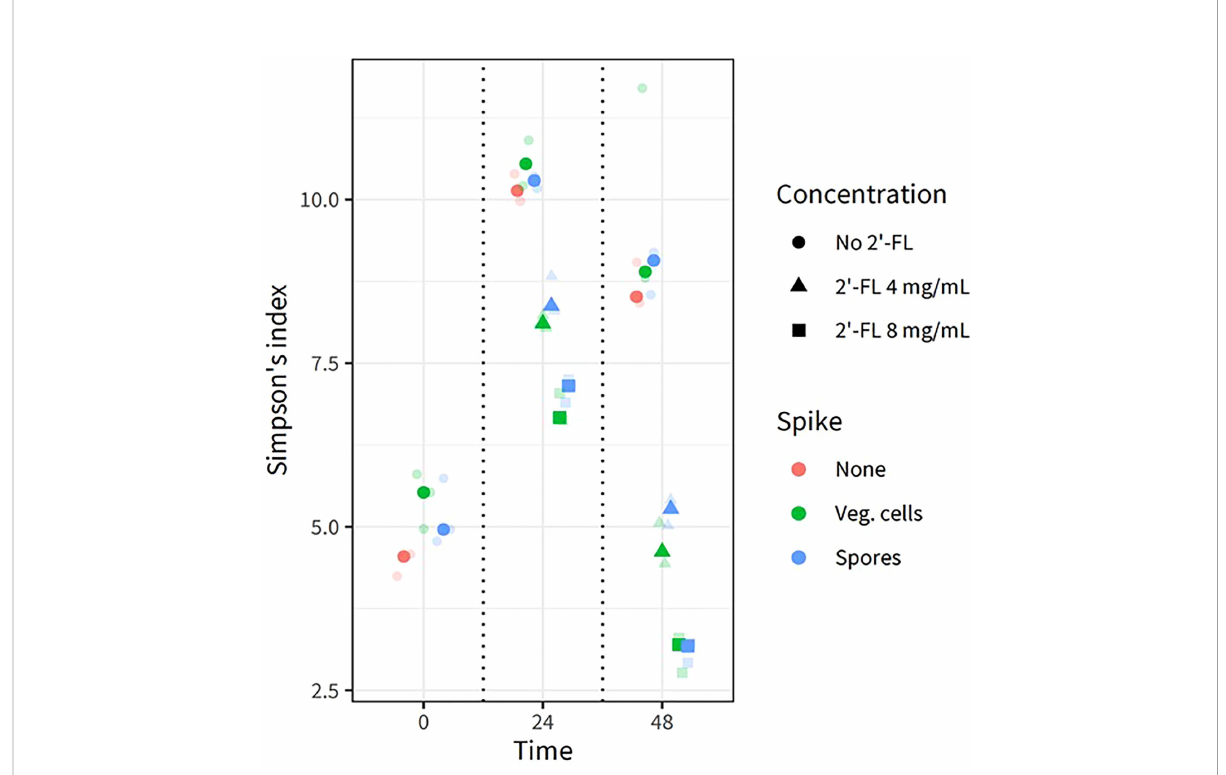
FIGURE 3 2 ’ FL affects the alpha diversity in the CDi-screen model Alpha diversity derived from 16S rRNA gene sequencing data of in vitro experiments is displayed as the Simpson Index (on the y-axis) for all experimental conditions and samples replicates as indicated by the different colored symbols. Each centroid shows its time point of sampling, with each sample shown in lower opacity. The fecal microbial community was analyzed without C. dif fi cile (red) as well as with C. dif fi cile vegetative cells (green) or spores (blue), and incubated in CDi-SIEM media at pH 6.0, without (circles) and with supplementation of the media with 2 ’ -FL at doses of 4 mg/mL (triangles) and 8 mg/mL (squares), and sampled at t=0 h, 24 h, 48 h (indicated on the